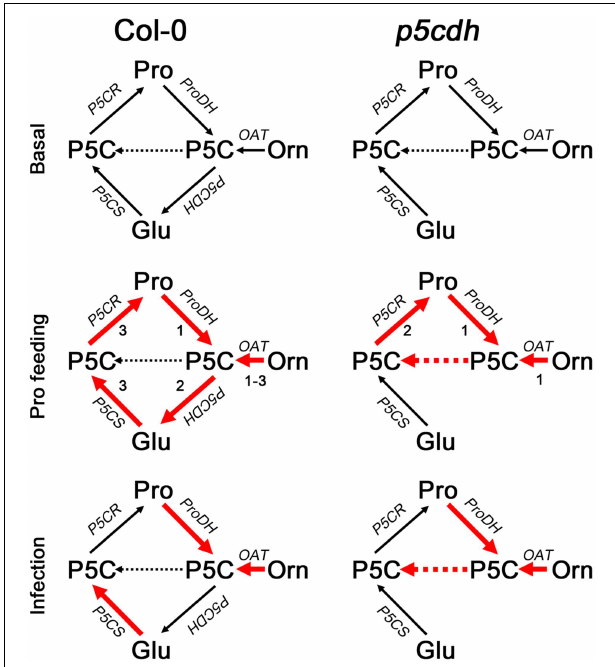
FIGURE 6 | Model of Pro metabolism in wild-type and p5cdh mutant plants. Metabolic routes are represented at basal condition (top), and after treatment with exogenous Pro (middle) or Pst-AvrRpm1 (bottom). Red lines represent gene activation. Numbers indicate the timing of gene induction according to results from Figure 4B . For further information see Discussion section.